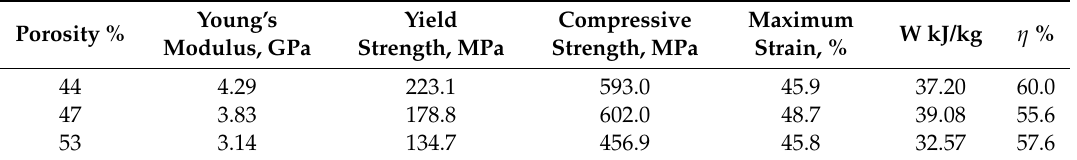
Table 2. The compressive properties and energy absorption properties of porous iron sintered by free pressureless